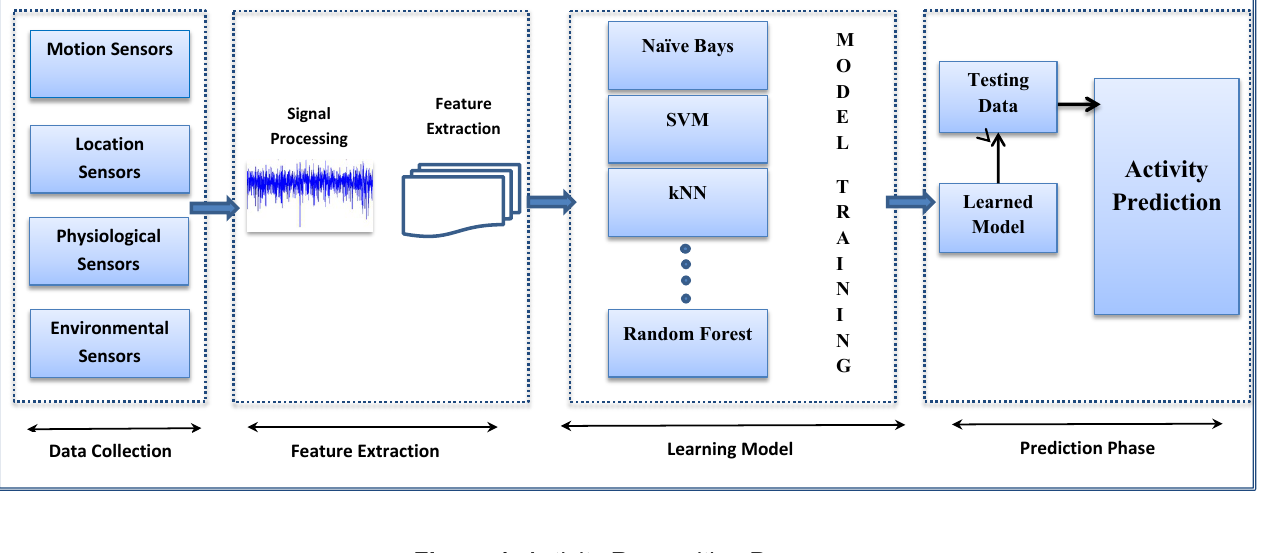
Figure 1. Activity Recognition